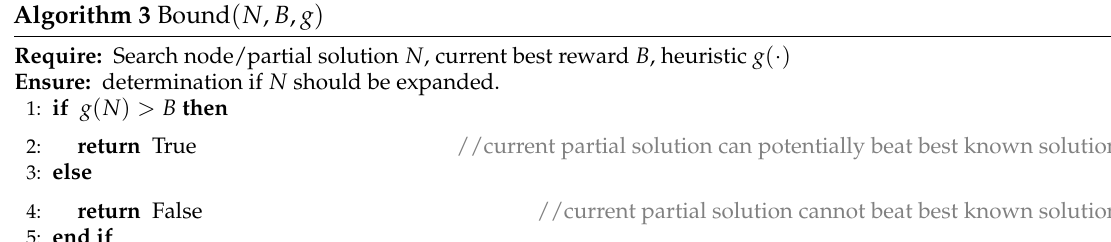
Algorithm 3 Bound ( N , B , g